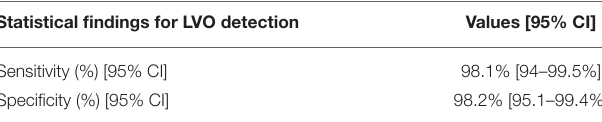
TABLE 6 | Performance metrics for overall cases of CINA-LVO